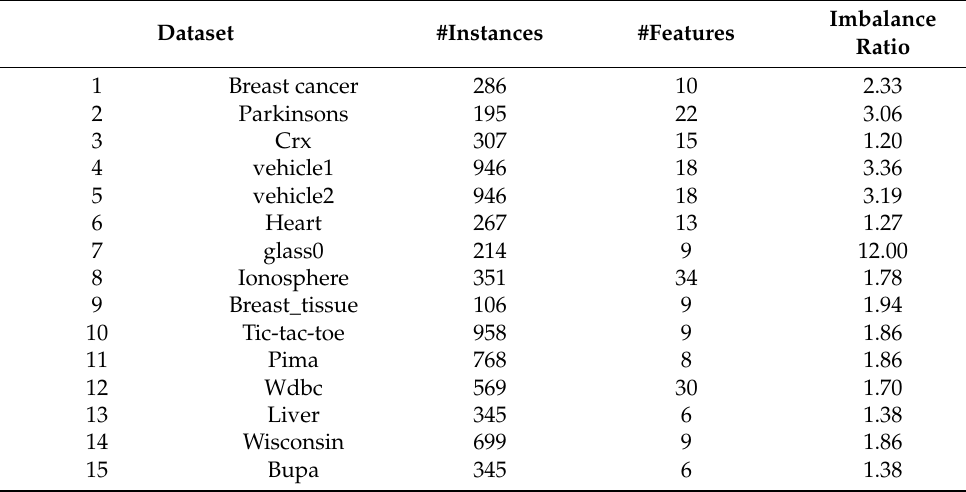
Table 7. Balanced and imbalanced datasets characteristics.